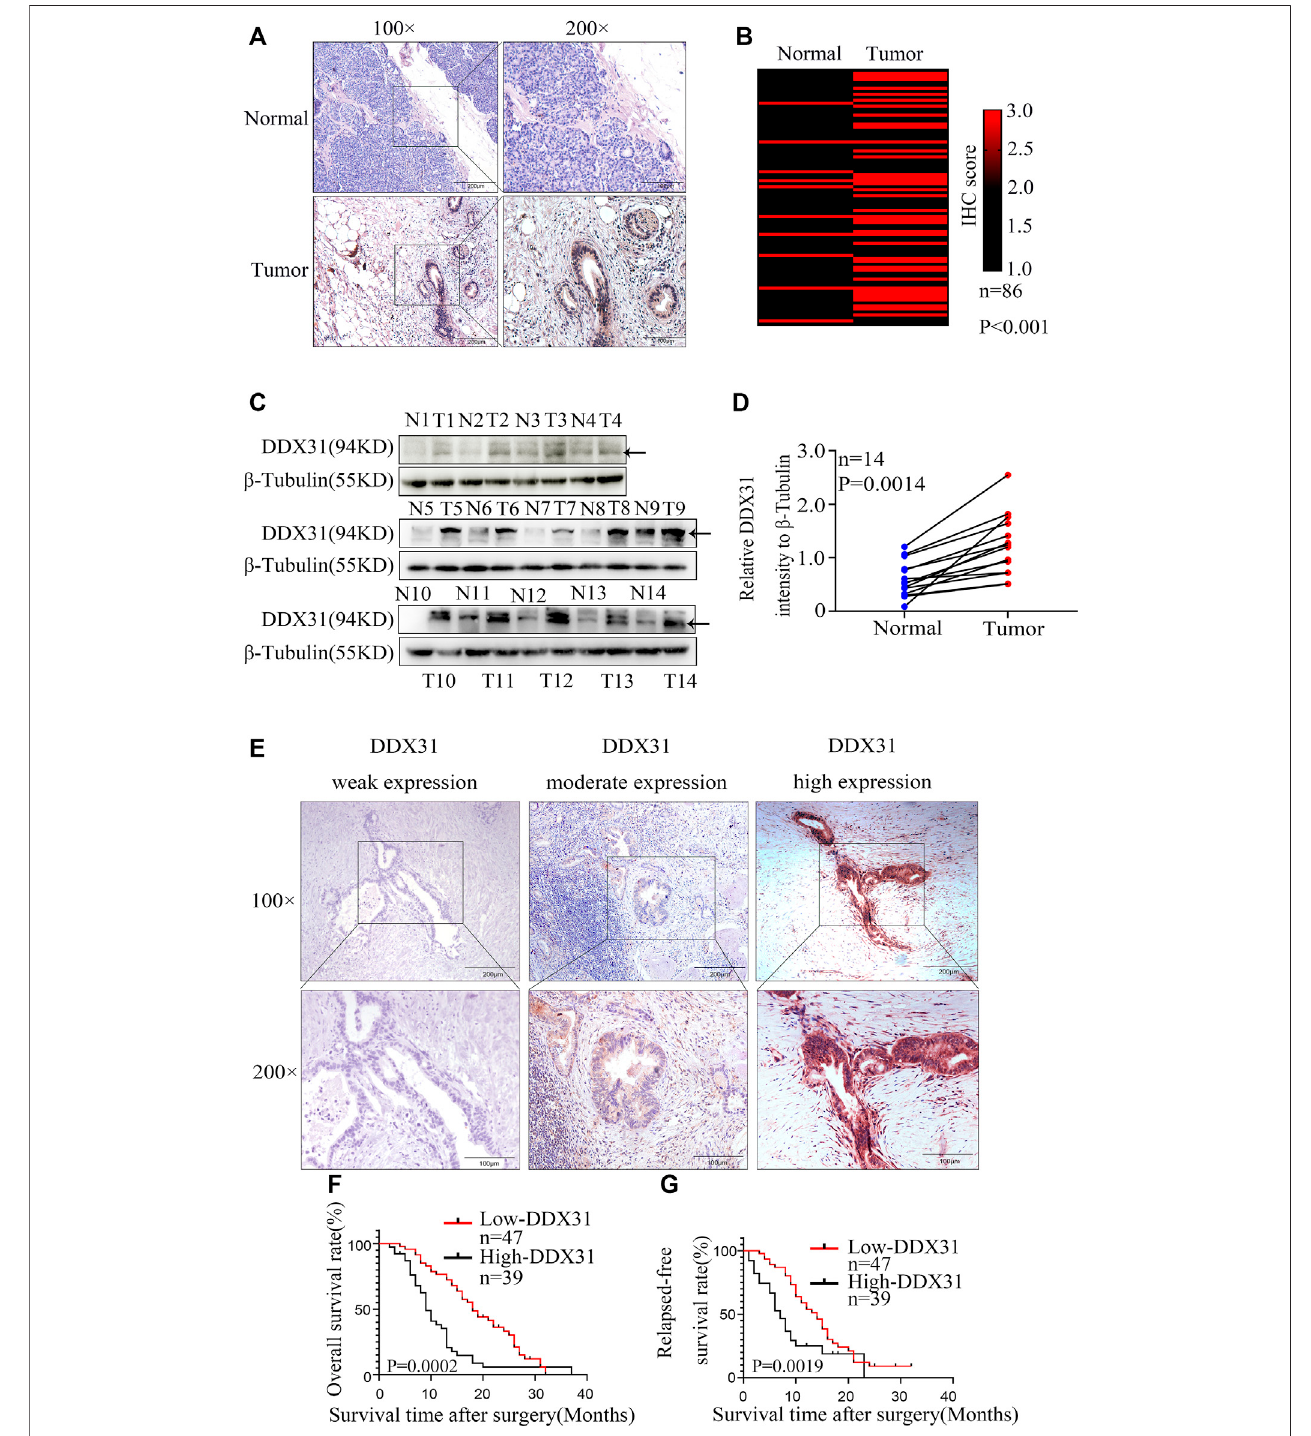
FIGURE 5 | Expression of DDX31 in PDAC tissue and its clinical signi fi cance. (A) : IHC analysis of DDX31 in PDAC (×100 and ×200 magni fi cation, bar = 200 and 100 μ m). (B) : The differential expression of DDX31 in 86 normal pancreas tissues and paired tumor tissues is shown in a heat map and was statistically analyzed by Wilcoxonsignedrank tests. (C) : Fourteen paired freshtumor tissues and normal tissues were attained, and Western blot analysis wasperformed toidentifythe elevated expression inPDACtissues comparedwithnormaltissues. (D) :Statisticalresult ofrelative DDX31 expression to β -tubulin Western blot isshown in Figure 7D . (E) : IHC stain of DDX31 in PDAC tissue paraf fi n section. Representative images for weak, moderate, and high expression of DDX31 in PDAC tissues are shown (×100 and ×200 magni fi cation, bar = 200 and 100 μ m). (F,G) : Difference analysis of overall survival (OS, L) rate and relapse-free survival (RFS, R) rate between DDX31 low- (weak and moderate expression) and high-expression group. * p <